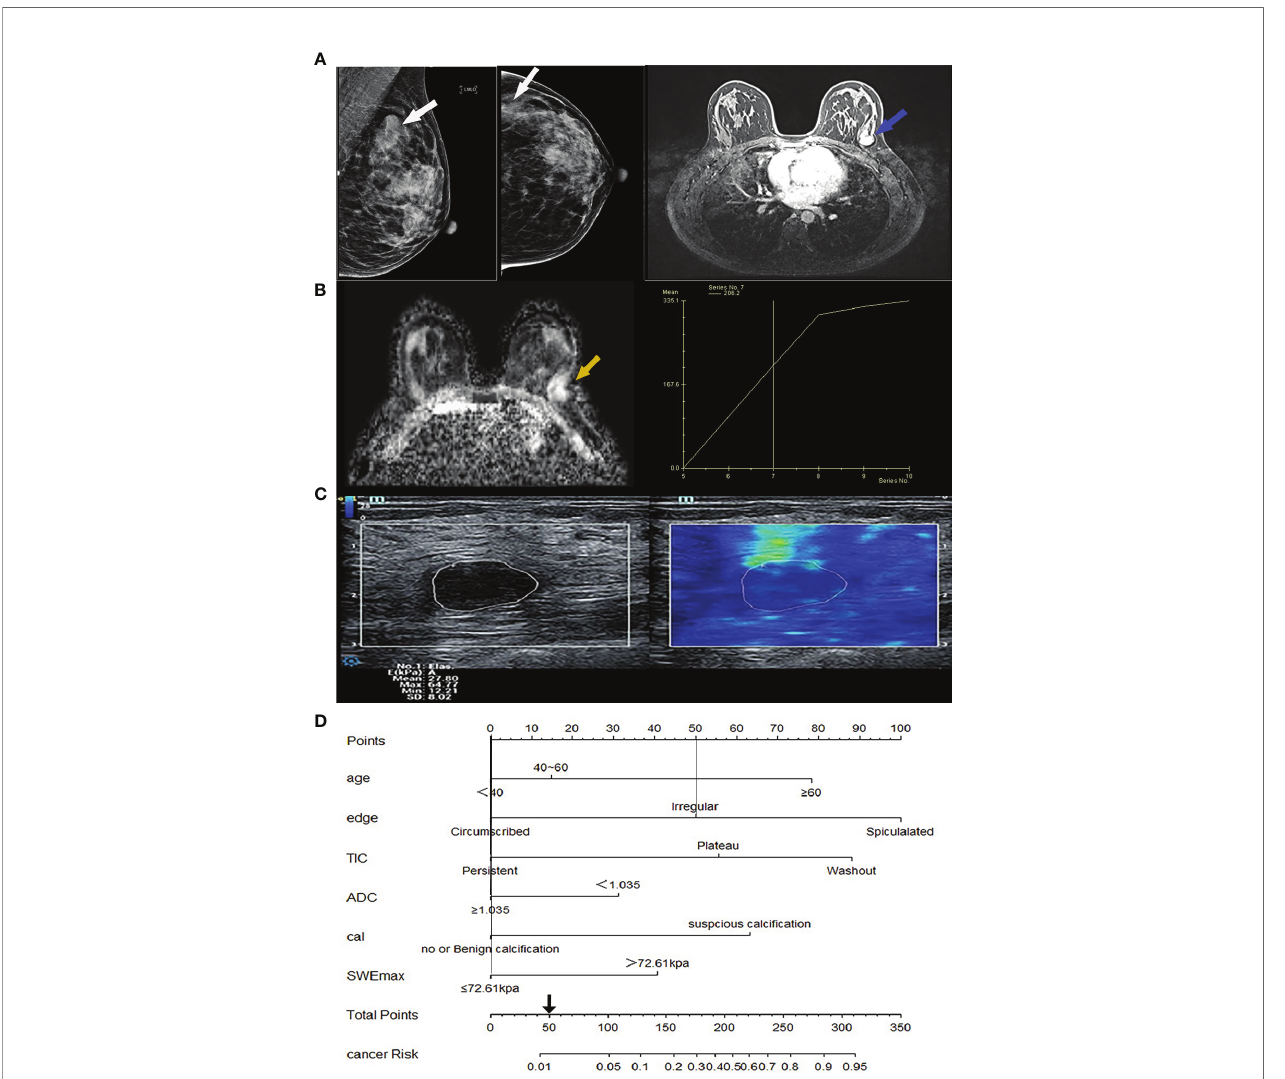
FIGURE 3 | Image from a 32-year-old woman suffering from fi broadenoma BI-RADS category 4A lesions. (A) Mammography imaging on the left (lesion indicated by white arrows) and the fi rst phase of magnetic resonance dynamic enhanced transverse axial images on the right (lesion indicated by blue arrows) showed a lobulated mass near the chest wall, without calci fi cation. (B) Magnetic resonance transverse axial ADC image showed a high signal value of 1.4 × 10 -3 mm 2 /s of the lesion on the left (indicated by yellow arrows) with ascending TIC curve on the right. (C) The ultrasound shear wave elastography shows SWEmax = 64.77 KPa. (D) In the comprehensive score of Nomogram, only the marginal irregularity (lobed) accounted for 50 points, which was less than 106 points, and it was downgraded into BI- RADS 3 category. cal, calci fi cation morphology; TIC, time-signal intensity curve; ADC, apparent diffusion coef fi cient.